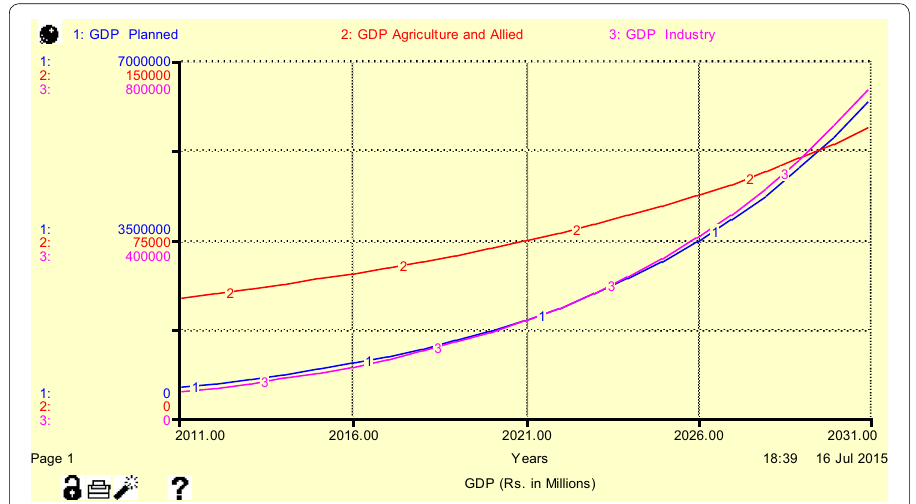
Fig. 16 Projected GDP, GDP in Agriculture and Allied Sector, and GDP in Industrial Sector up to year